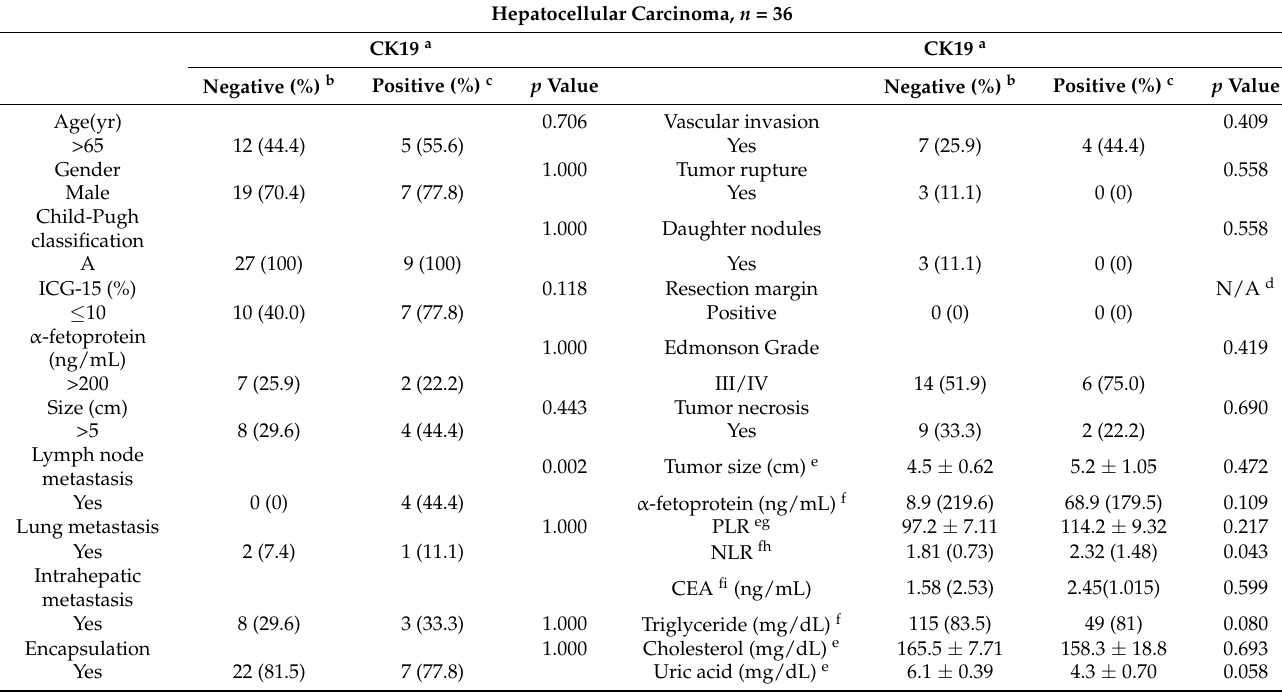
Table 2. The relationship between clinicopathological variables and CK19 expression in hepatocellular carcinoma.